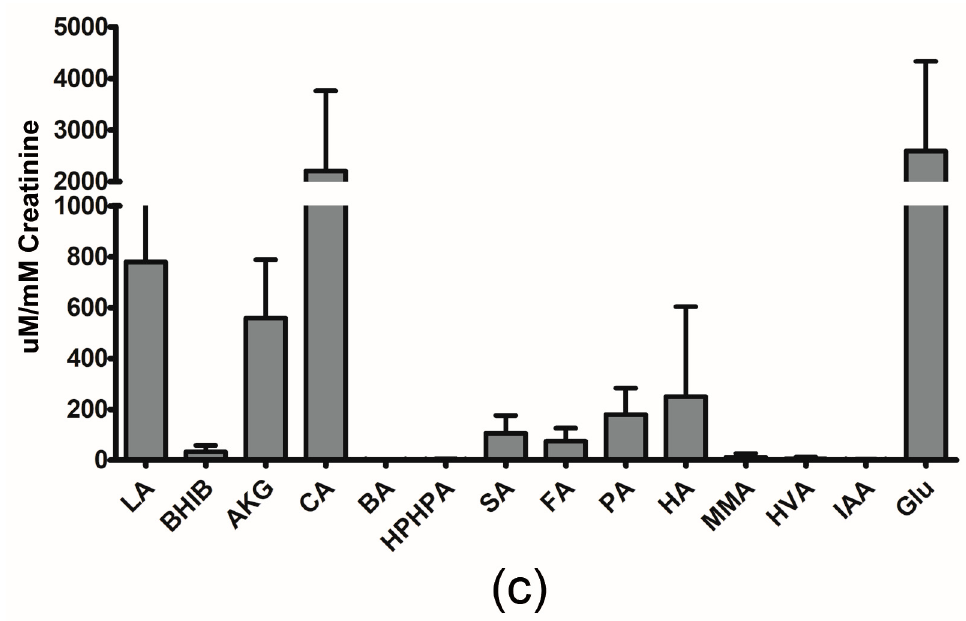
Figure 1. Graphical representation of urinary concentrations of ( a ) amino acids ( b ) biogenic amines and ( c ) organic acids, previously reported in newborns by LC-MS / MS. The error bars reflect one standard deviation. ( a ) Amino acids are represented by their three-letter code. ( b ) 4-hydroxyproline: Hyp;